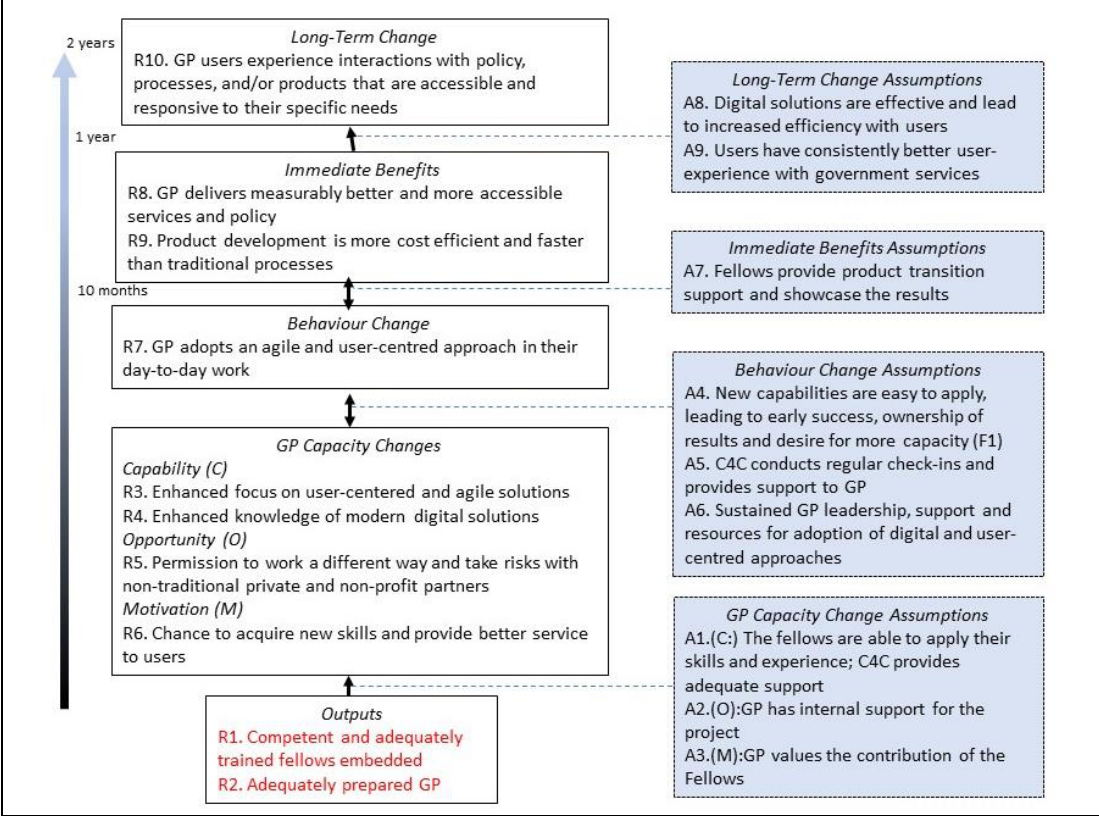
Figure 5: Code for Canada Fellowship Theory of Change Story 2 (GP Product Development and